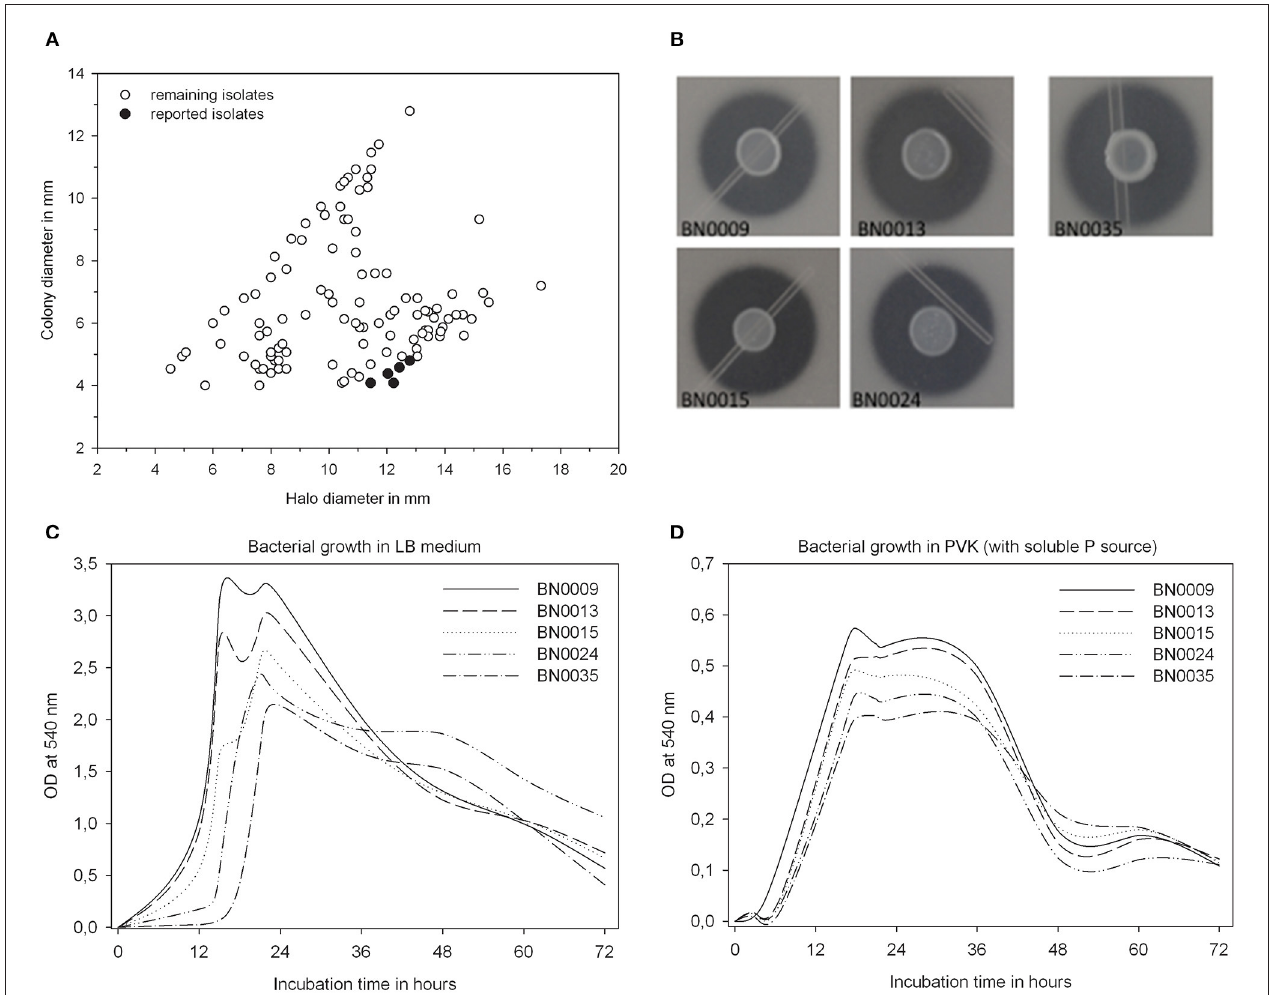
FIGURE 1 | Solubilization capacity, colony morphology, and characterization of the bacterial growth; (A) solubilization capacity of all isolates in the screening, shown as ratio of halo vs. colony diameter (highlighted in black the reported isolates); (B) colony morphology and halo size of the five reported isolates on PVK plates; (C,D) bacterial growth in LB and PVK (with soluble P) liquid media for the reported